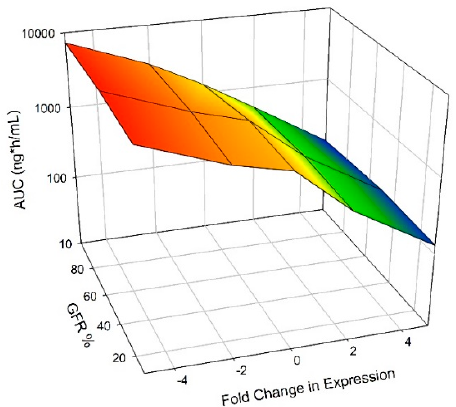
Figure 2. Impact of CYP3A4 Expression on AUC of Nifedipine. CYP3A4 expression was varied ± 2- and ± 5-fold. A dose of 60 mg was administered orally to an exclusively male population in a fasted state. Simulations included ten trials with ten individuals in each. Age ranged from 21 to 65 years, and simulations were conducted with varying the degrees of RI by utilizing the following populations, Sim-Healthy Volunteers, Sim-RenalGFR_30-60, and Sim-RenalGFR_less_30 to represent 100%, 50% and 10% GFR.